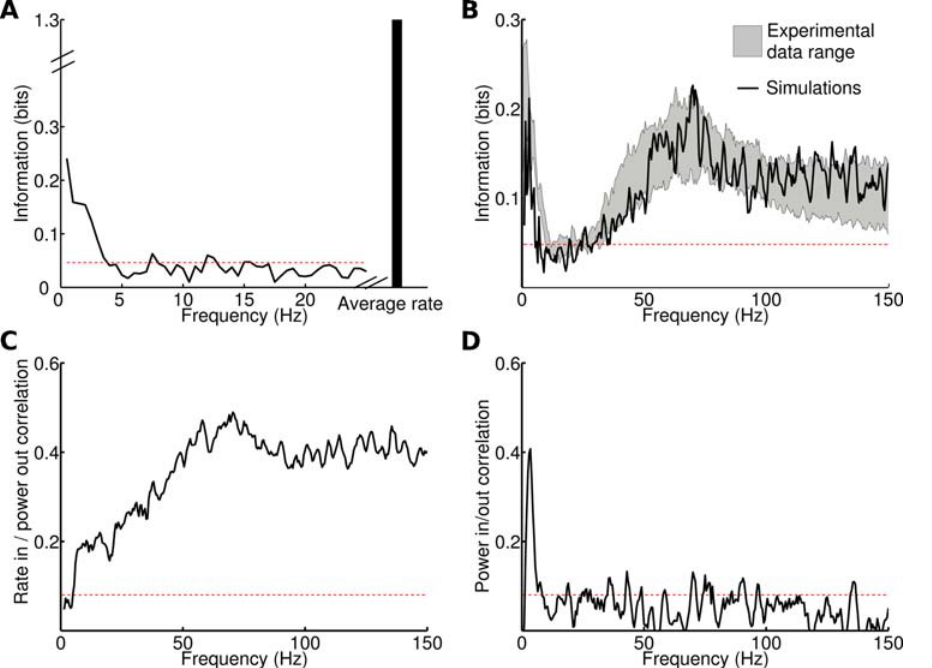
Figure 7. Information content relative to naturalistic stimuli, based on MUA recordings from LGN of an anesthetized monkey watching natural movie scenes. Recording time (40 seconds) was divided into 20 intervals, considered as different signals. Each signal was injected 20 times with different noise realizations (see Methods). Red dashed horizontal line indicates significance threshold (p , 0.05; bootstrap test) in all panels. (A) Information content of different frequencies and average rate of naturalistic input. (B) Information content, relative to naturalistic inputs, of simulated LFP (in black) compared with the information content of LFP recorded in V1 in the same experiment from which LGN data were taken. Gray area represents the mean 6 std range of information across 7 different electrodes recording synchronously from different sites. (C–D) Correlation between LFP spectrum and signal features. (C) Correlation between stimulus rate and power of LFP frequencies in the response. (D) Correlation between the power of each frequency in the stimulus spectrum, and its power in the corresponding LFP spectrum.